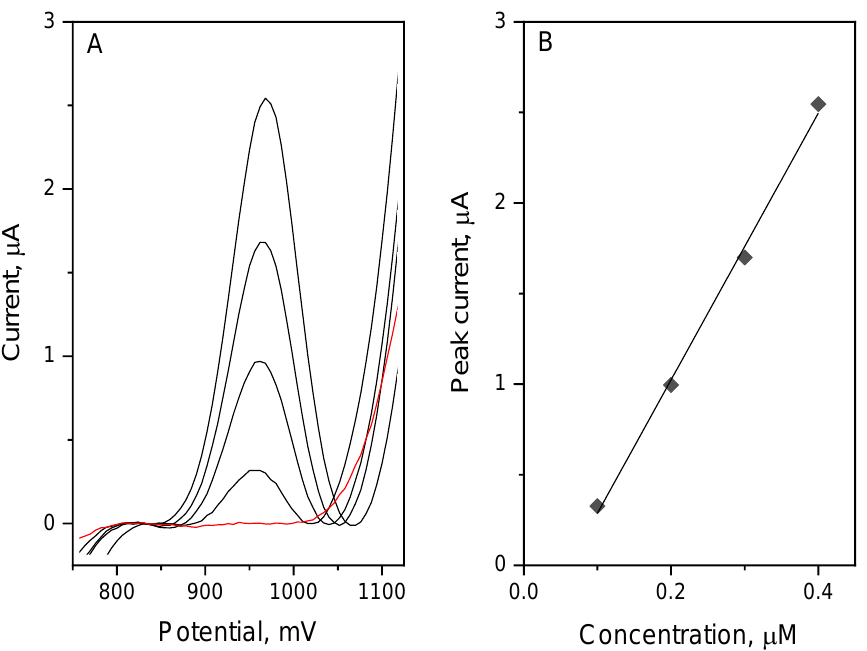
Figure 8. SWV vortioxetine voltammograms registered in plasma sample after background correction (plasma background voltammogram marked as red) ( A ) with corresponding calibration curve ( B ). Other instrumental parameters as in point 2.7. Table 2. Results of vortioxetine determination in samples: tablets, urine, and plasma.